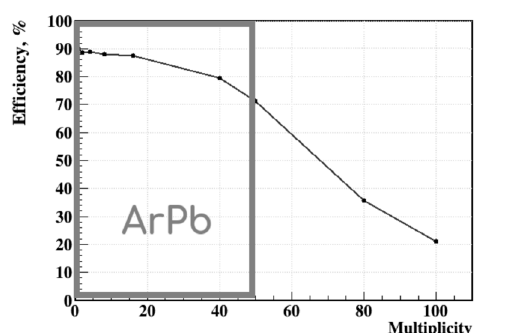
Figure 4. Dependence of the tracking e ffi ciency on the particle multiplicity in